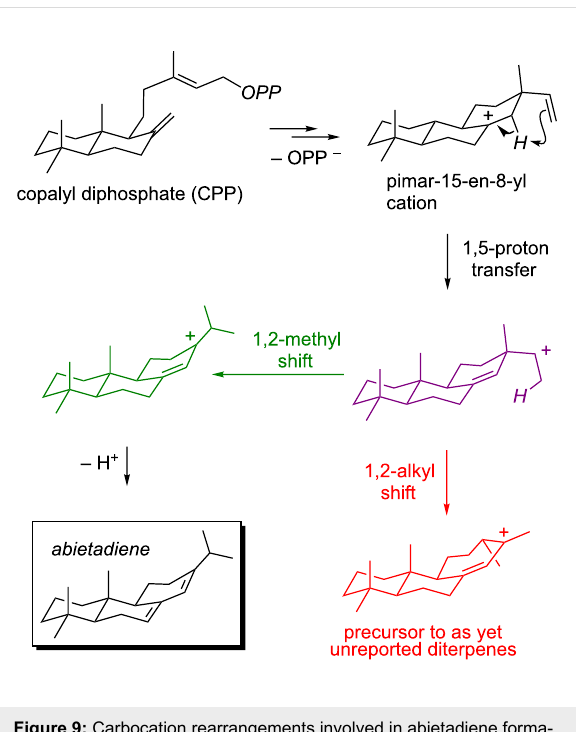
Take home messages: